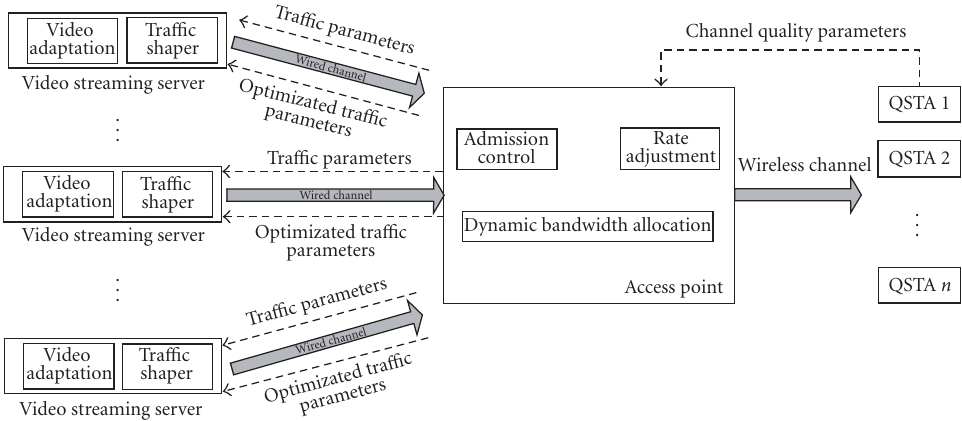
Figure 4: The cross-layer architecture for video streaming over